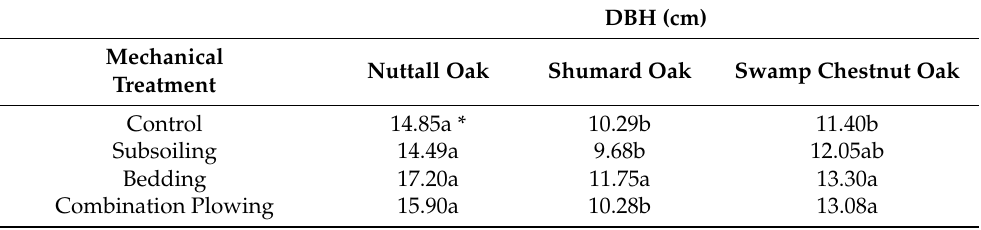
Table 1. Analysis of diameter of oak trees by species and mechanical site preparation treatment at 11 years